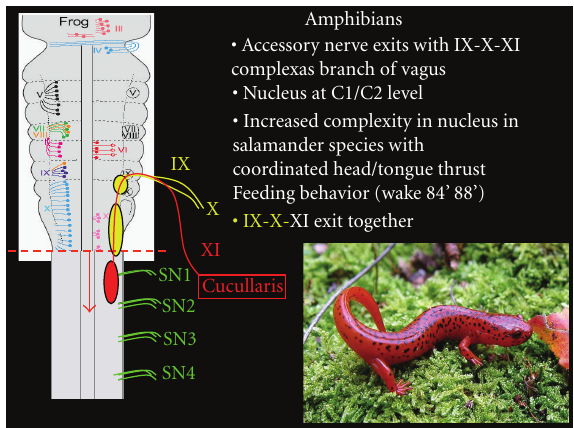
Figure 7: In amphibians, the accessory nerve continues to exit with the glossopharyngeal-vagus complex, however the nucleus has seperated in many species and is located within the spinal column. The accessory nerve innervated the cucullaris musculature which is associated with neck movement and feeding behavior. The accessory nerve is believed to have a universal presence in amphibians. The accessory nerve arises from a nucleus that overlaps portions of the upper cervical nerves. The nerve fibers exit via the IX, X, XI